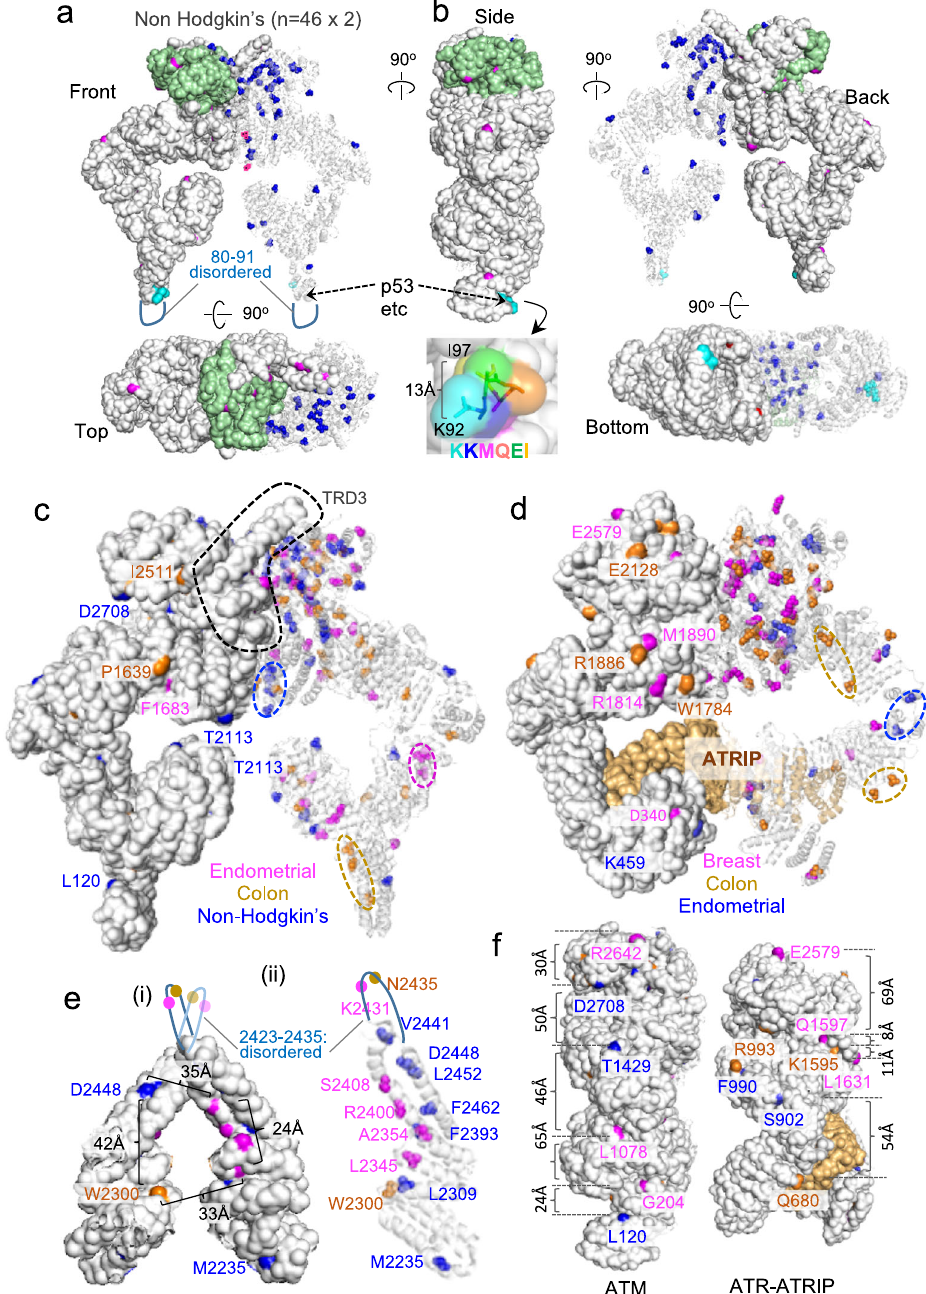
Fig. 3 Molecular modeling of the conserved ATM and ATR residues mutated in cancer. a The conserved 46 ATM residues mutated in non-Hodgkin ’ s lymphoma but not in endometrial or colon cancers (Fig. 2c and Supplementary Data 3) are mapped onto a cryo-EM model of the dimeric ATM complex (PDB 5NPO, 5.70 Å) 9 . The protomer on the right-hand side is in cartoon representation and allows visualization of all 46 residues (blue). The protomer on the left-hand side is shown in surface representation to identify residues that are readily visible on the surface among the 46 (magenta). Green: kinase domain. Upper and lower panels show a view from the front and the top. Cyan: residues 92 – 97 involved in binding to several ATM-interacting proteins, including p53 (ref. 47 ). Residues 80 – 91 are in a disordered region and missing in the model 9 . b The side, back, and bottom views of the image in a . Also shown are the surface representation of the region around the seven residues involved in p53 binding and the distance between the K92 and I97 in Å. c Same as a except that the complex is showing residues mutated in non-Hodgkin ’ s lymphoma ( n = 46; blue), endometrium cancer ( n = 40; magenta), or colon cancer ( n = 38; brown; Supplementary Data 3). TRD3: a regulatory motif examined in detail in e . Dashed oval: an area enriched for the residues mutated in the given cancer type. d Same as in c , but for ATR residues mutated in cancers of breast ( n = 27; magenta), colon ( n = 27; brown), or endometrium ( n = 28; blue; Supplementary Data 4). The ATR model used: PDB 5YZO, 4.70 Å (ref. 10 ). e A higher resolution image of the TRD3 in c . (i) The TRD3 motifs from both protomers are shown in surface representation to visualize solvent accessible residues among the mutated residues. The 22 residues between 2423 and 2435 are disordered and missing in the model 9 . (ii) The right-hand side TRD3 motif is shown in cartoon representation to enable visualization of all mutated residues. f A side view of the images shown in c and d , showing the distances between some of the solvent accessible